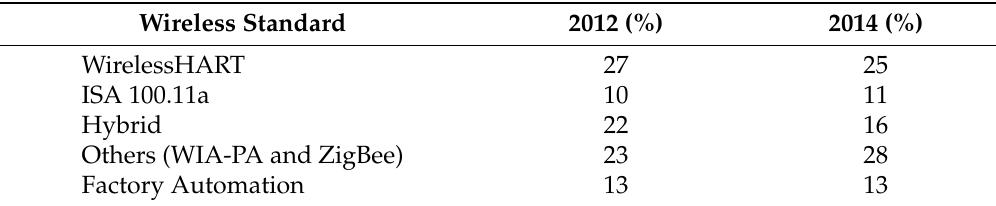
Table 4. Preferred IWSN standards [12].